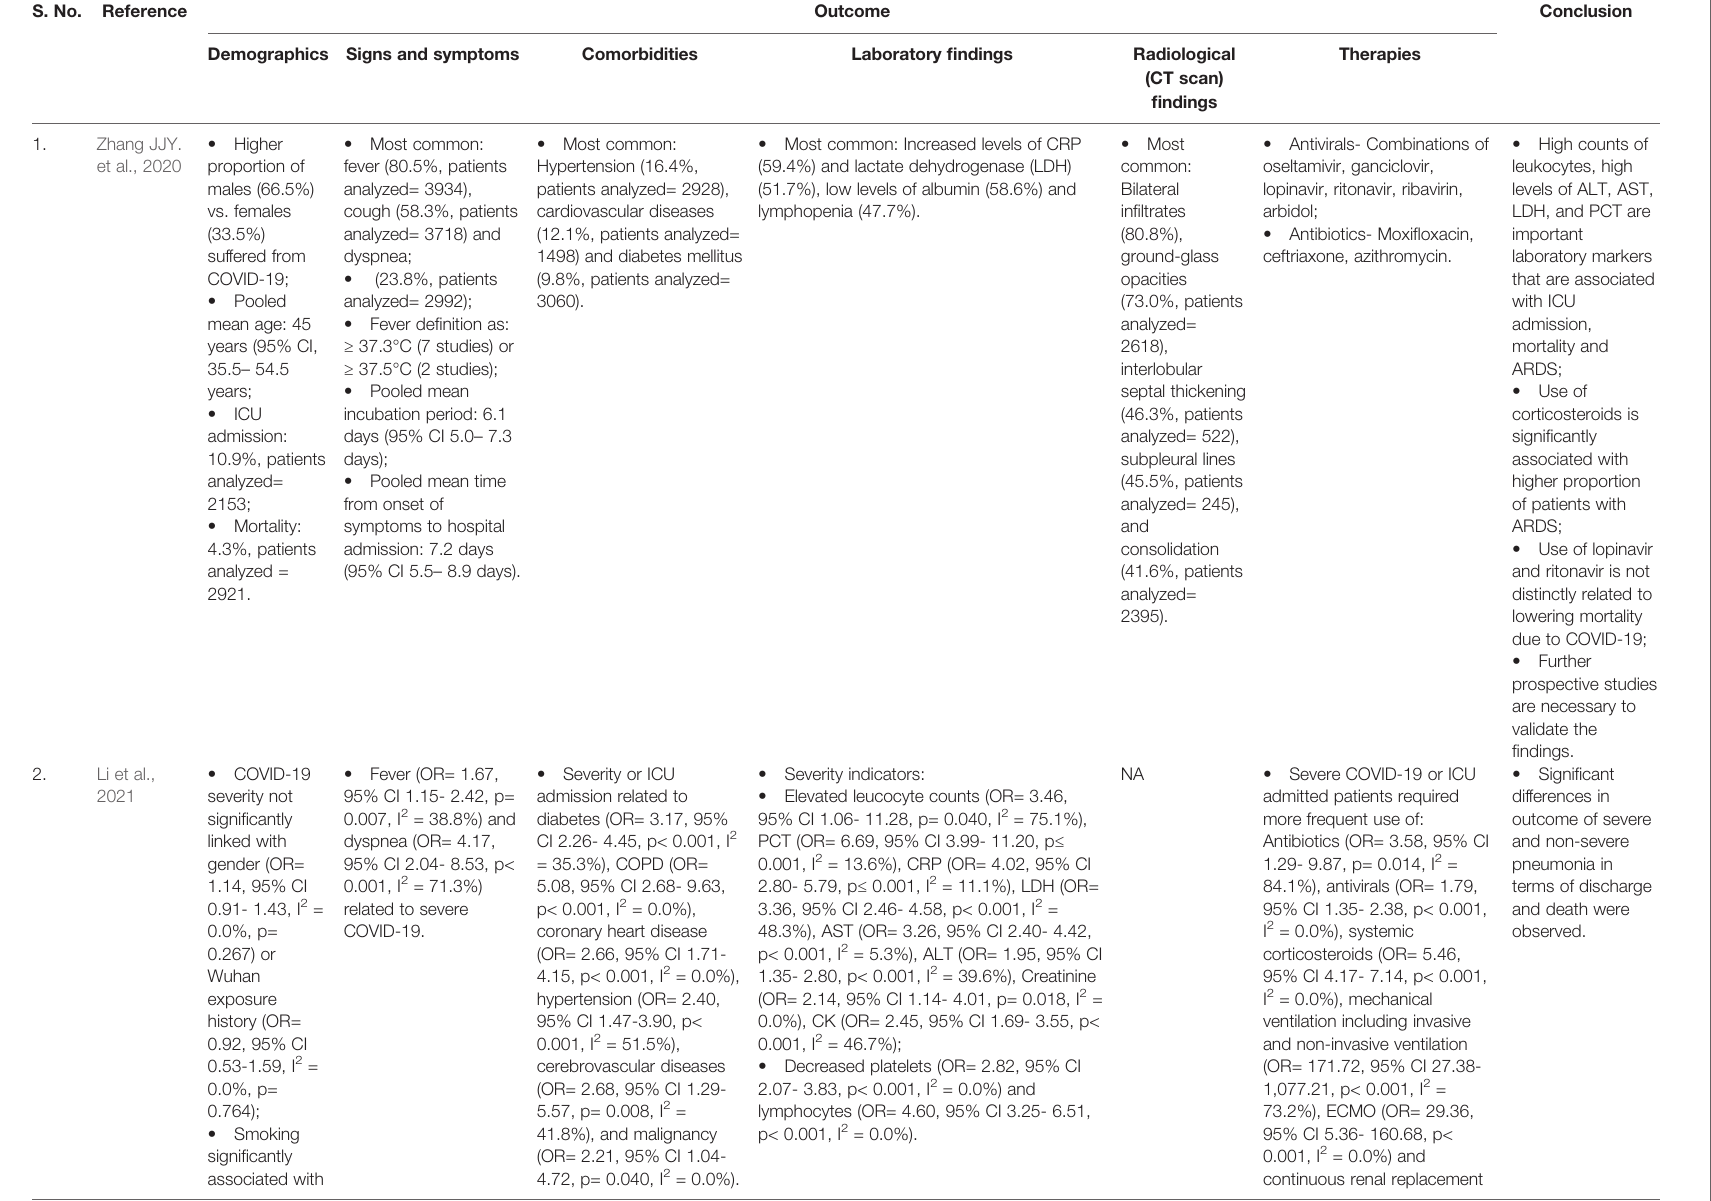
TABLE 1B | Summary of the major outcomes of the analyzed systematic reviews and meta-analyses. S. No.